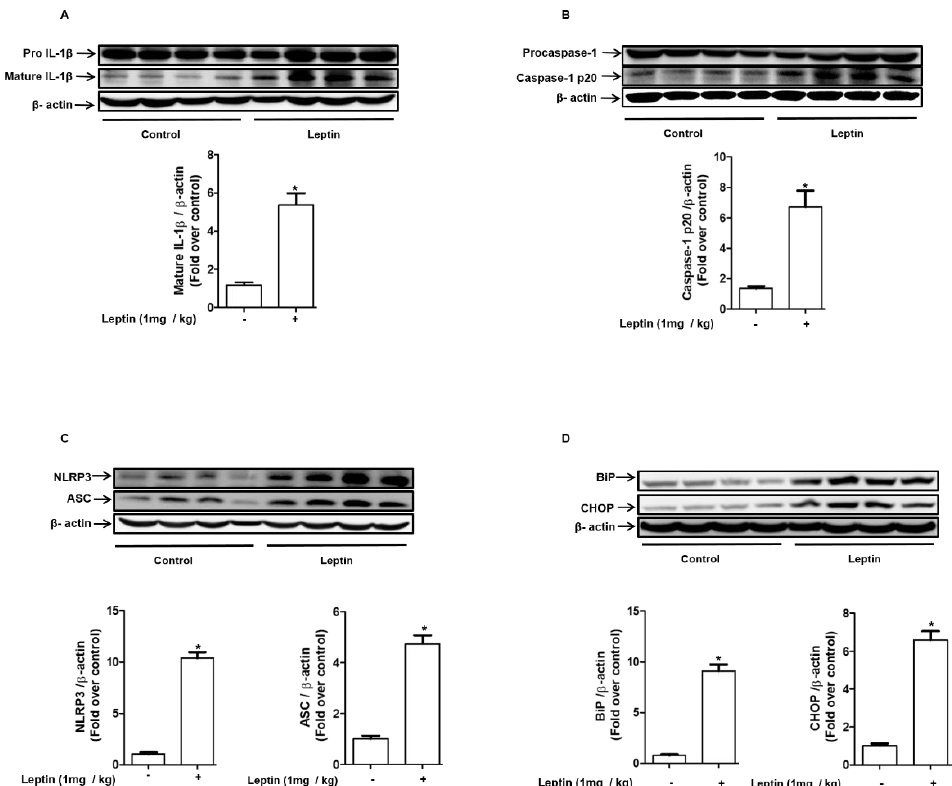
Figure 7. Effects of leptin on inflammasome activation and ER stress in rat liver: Rats were administered leptin for 10 days at a dose of 1mg/kg/day. After liver excision, total cellular extracts were prepared as described in the Methods section and were used for Western blot analysis to determine the expression levels of active IL-1 β ( A ), caspase-1 ( B ), NLRP3, ASC ( C ), Bip, and CHOP ( D ), which are marker genes for inflammasomes and ER stress. Expression levels of the proteins were quantified by densitometric analysis and are presented in the lower panel of each image. Values presented as mean ± SEM, n = 4. * represents p < 0.05 compared to control rats.